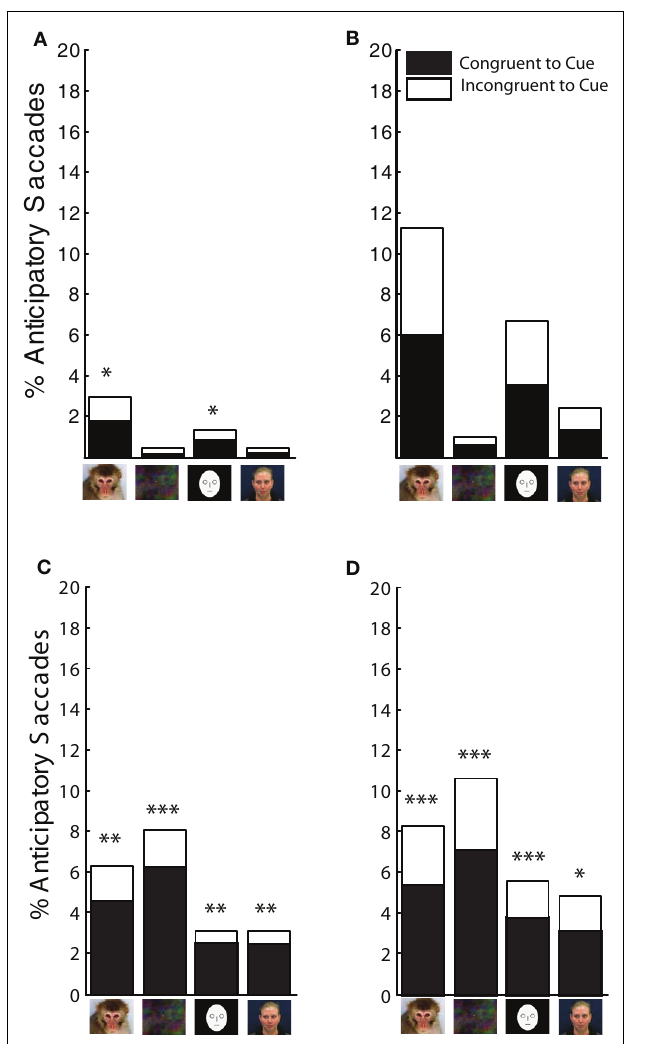
FIGURE 8 | Distribution of microsaccades in RO and LO tasks. (A) Proportion of trials with microsaccades in the static RO task as a function of cue type. Binominal tests demonstrated that percentages of congruent-to-cue microsaccades were above chance for monkey-face and cartoon-face cues (* p < 0.05, ** p < 0.01, *** p < 0.001). (B) For the dynamic RO task, fewer than 5% of trials with microsaccades were observed across all stimulus types. Percentages of congruent-to-cue microsaccades were above chance for monkey-face and cartoon-face cues. (C,D) In the LO task the percentages of congruent-to-cue microsaccades were above chance for all stimulus types for the 0 distractor (C) and 1 distractor trials (D)